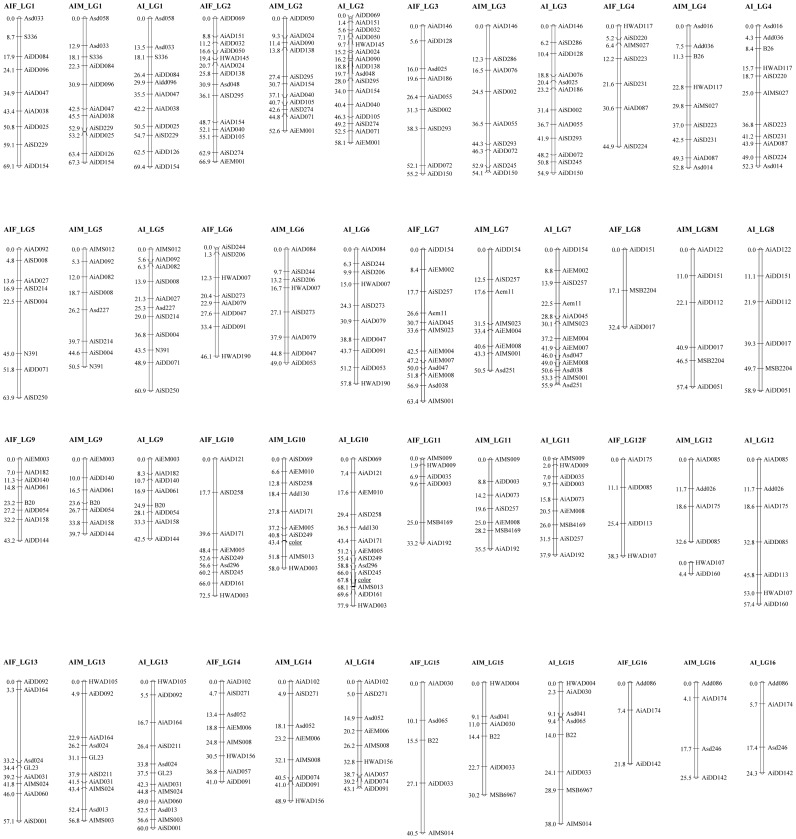
Consensus microsatellite-based linkage map for bay scallop (Argopecten irradians) constructed using two hybrid backcross-like families.The female linkage group (left) is named as “AiF_LG”; the male linkage group (middle) is named as “AiM_LG”; the sex-averaged linkage group (right) is named as “Ai_LG”. The phenotypic maker (shell color) placed on LG 10 was underlined.